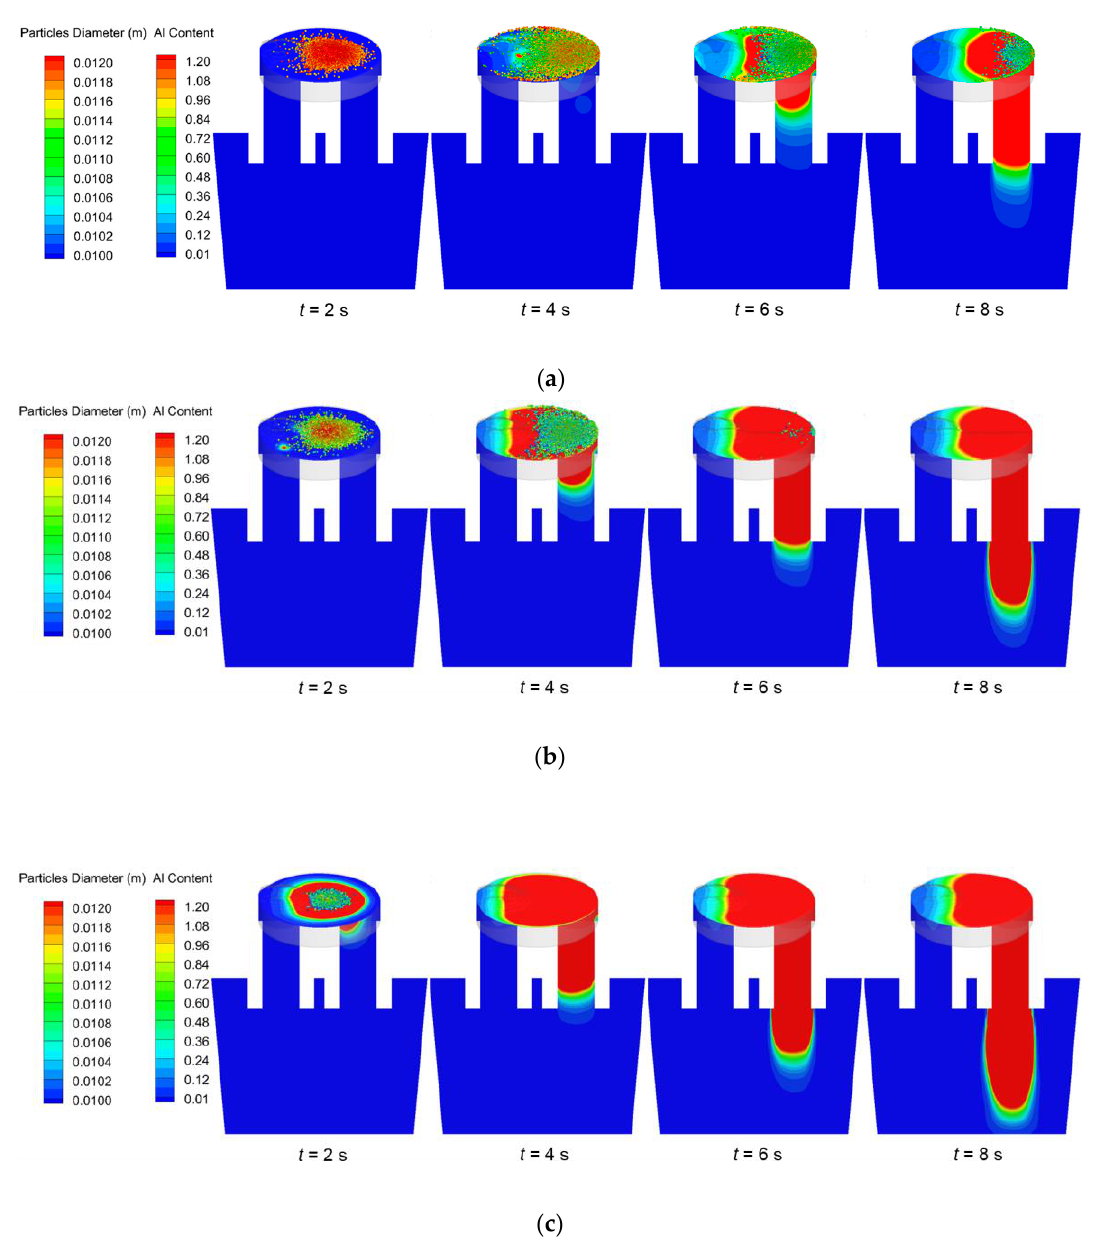
Figure 8. Aluminum particles’ melting process under different superheats: ( a ) Superheat = 10 K; ( b ) superheat = 20 K; ( c ) superheat = 60 K.